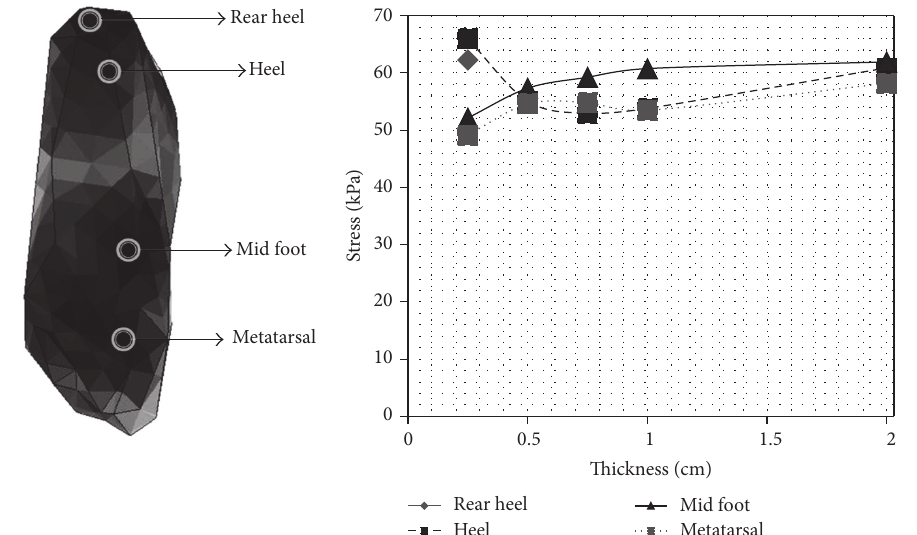
Figure 3: Variation of stress value in each region by changing the thickness for custom-molded insoles. The stress is well distributed over the whole foot. Moreover, increasing the thickness does not necessarily lead to less maximum stress after around 0.75 cm thickness of the insole.